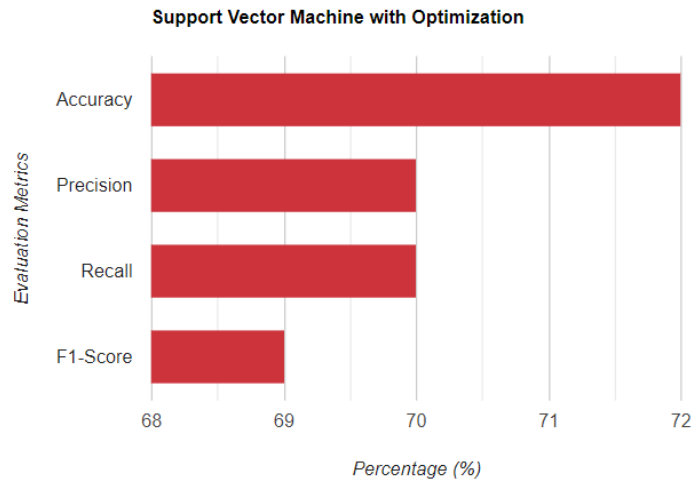
Figure 14. The SVM Classifier Performance After Optimization.